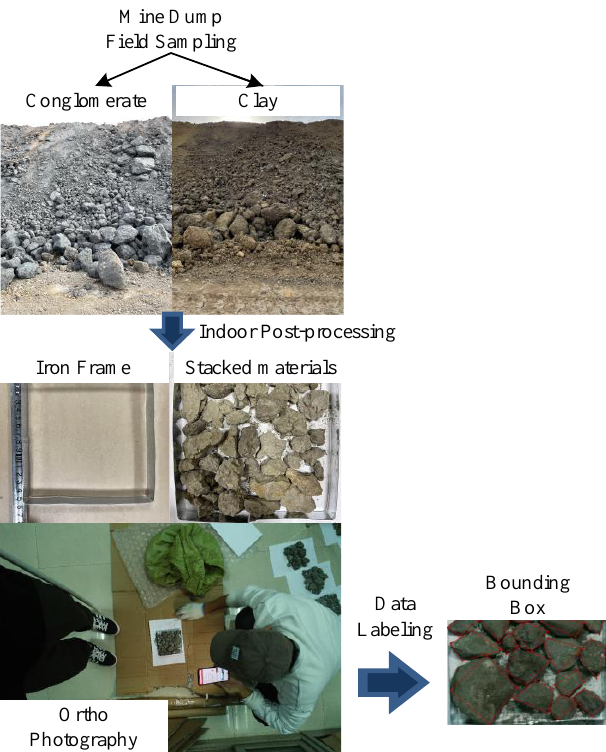
Figure 3. Illustration of the full process for producing a dataset. Firstly, the material collection is performed in a specific mine dump. Secondly, post-processing of the collected material is performed indoors. Finally, the data are